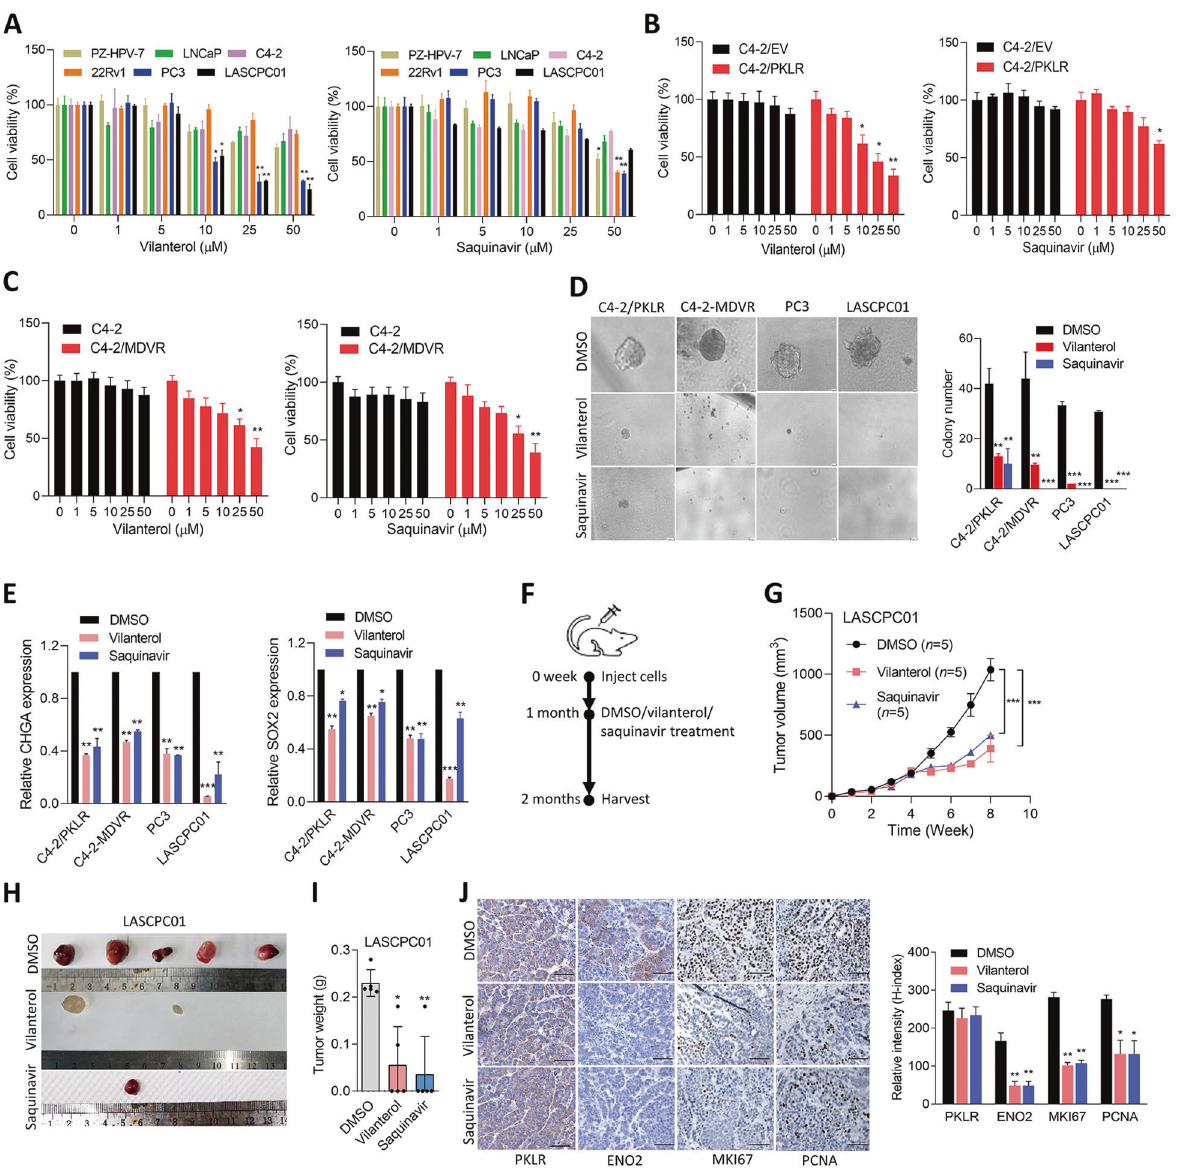
Fig. 6 Inhibition of PKLR may be a promising therapeutic strategy of NE-like PCa. A Various prostatic cell lines were treated with 0, 1, 5, 10, 25, and 50 μ M vilanterol (left) or saquinavir (right) for 24 h, and cell viability was determined by an MTT colorimetric assay. n = 8 per group. * vs. the vehicle (0 μ M); by a one-way ANOVA. B Proliferation analysis of C4-2 cells expressing an empty vector (EV) or PKLR cDNA vector, and treated with 0, 1, 5, 10, 25, and 50 μ M vilanterol (left) or saquinavir (right) for 24h. n = 8 per group. * vs. the vehicle (0 μ M); by a one-way ANOVA. C Proliferation analysis of C4-2 and C4-2-MDVR cells treated with 0, 1, 5, 10, 25, and 50 μ M vilanterol (left) or saquinavir (right) for 24h. n = 8 per group. * vs. the vehicle (0 μ M); by a one-way ANOVA. D Sphere-formation assays of C4-2/PKLR, C4-2-MDVR, PC3, and LASCPC01 cells exposed to the vehicle (DMSO), vilanterol (10 μ M), or saquinavir (10 μ M) for 1 week. n = 8 per group. * vs. DMSO; by a one-way ANOVA. Quanti fi cation of cell viability and sphere formation presented as the mean ± SEM from three biological replicates. *p < 0.05, ** p < 0.01, *** p < 0.001. E Relative CHGA (left) and SOX2 (right) mRNA levels in C4-2/PKLR, C4-2-MDVR, PC3, and LASCPC01 cells with DMSO, 10 μ M vilanterol, or 10 μ M saquinavir treatment for 24h. * vs. DMSO; by a one-way ANOVA. Quanti fi cation of mRNA is presented as the mean ± SEM from three biological replicates. *p < 0.05, ** p < 0.01, *** p < 0.001. F Scheme for the treatment of LASCPC01 and C4-2-MDVR xenografts with vilanterol and saquinavir. Male nude mice bearing established LASCPC01 or C4-2-MDVR tumors were treated with DMSO, 25mg/kg body weight (BW) vilanterol, or 25mg/kg BW saquinavir starting 1 month after the tumor injection, twice a week for 4 weeks. G – I Tumor growth analysis of mice subcutaneously inoculated with LASCPC01 cells. Tumor sizes were monitored once a week ( G ), images ( H ), and tumor weights ( I ) were obtained at the end of the experiment ( n = 5 mice per group). * vs. DMSO. * p < 0.05, ** p < 0.01; by a one-way ANOVA. J IHC staining and representative intensities of PKLR, ENO2, MKI67, and PCNA in subcutaneous tumors from ( H ). * vs. DMSO. Signi fi cance was determined by a two-tailed Student ’ s t -test. * p < 0.05, ** p < showed that C4-2/PKLR or C4-2-MDVR cells treated with vilanterol and saquinavir exhibited signi fi cantly reduced growth rates compared to cells treated with other drugs (Fig. 6B, C and Fig. S8A). To test the speci fi city of targeting PKLR, C4-2 cells with Supplementary Fig. S8B – D). Vilanterol and saquinavir did not PKLR overexpression (C4-2/PKLR) or MDV3100-resistance (C4-2- signi fi cantly decrease sphere formation of parental C4-2 and MDVR) were treated with these small-molecule drugs, and results